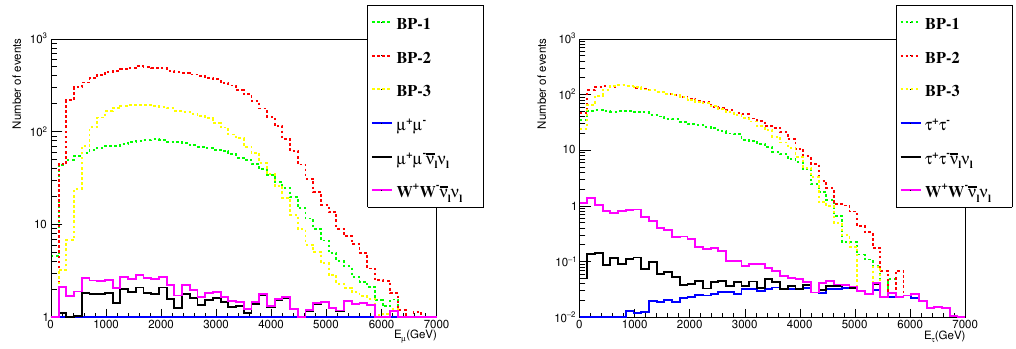
Figure 12 . Same as figure 8, but for the mono-photon signature.